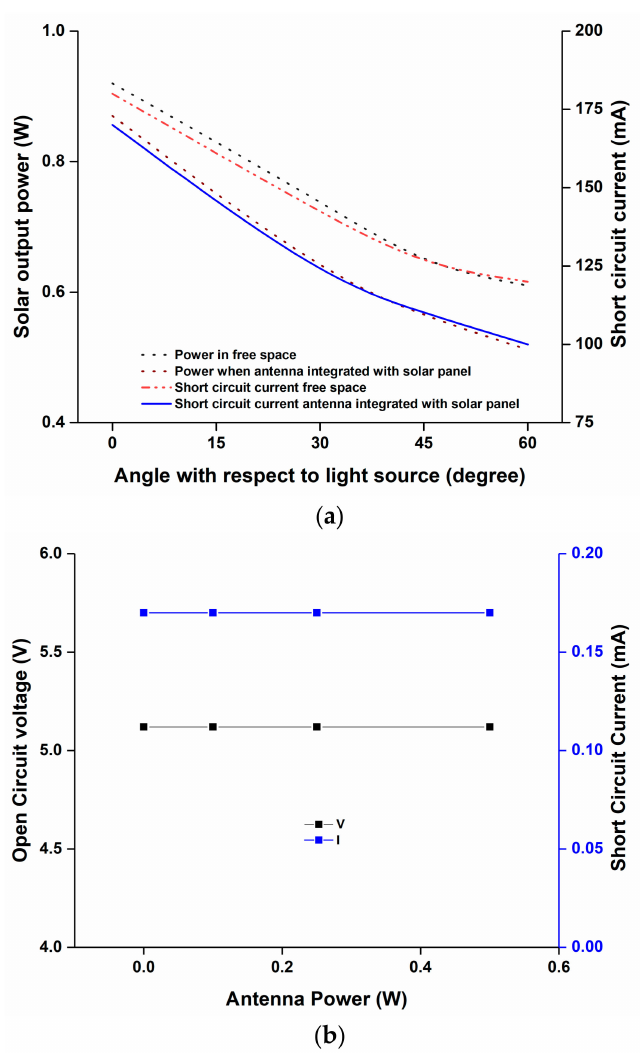
Figure 11. ( a ) Solar output power and short circuit current measurement without and with antenna placement; ( b ) Solar characterization with varying antenna power from 0.1 W to 0.5